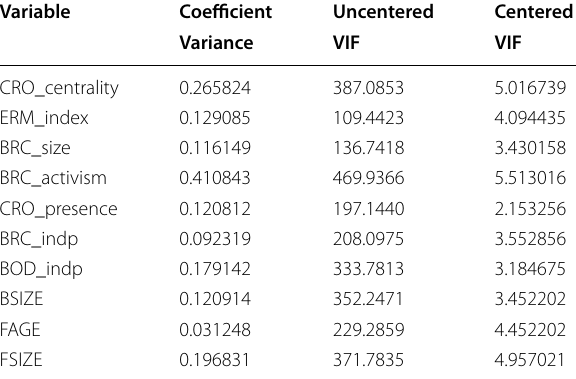
Table 4 Variance inflation factor